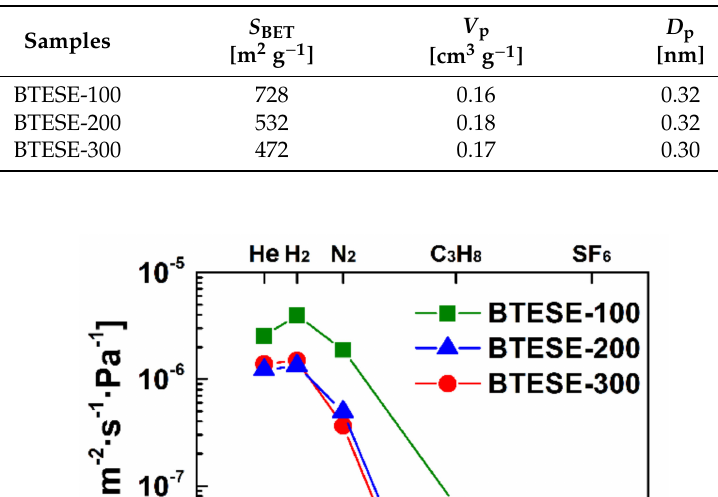
Figure 2. ( a ) N 2 adsorption-desorption isotherms (solid: adsorption, dot: desorption) and ( b ) pore size distribution (calculated by MP method) of BTESE xerogels with di ff erent calcination temperatures. Table 2. Textural properties of the samples with di ff erent calcination temperatures.